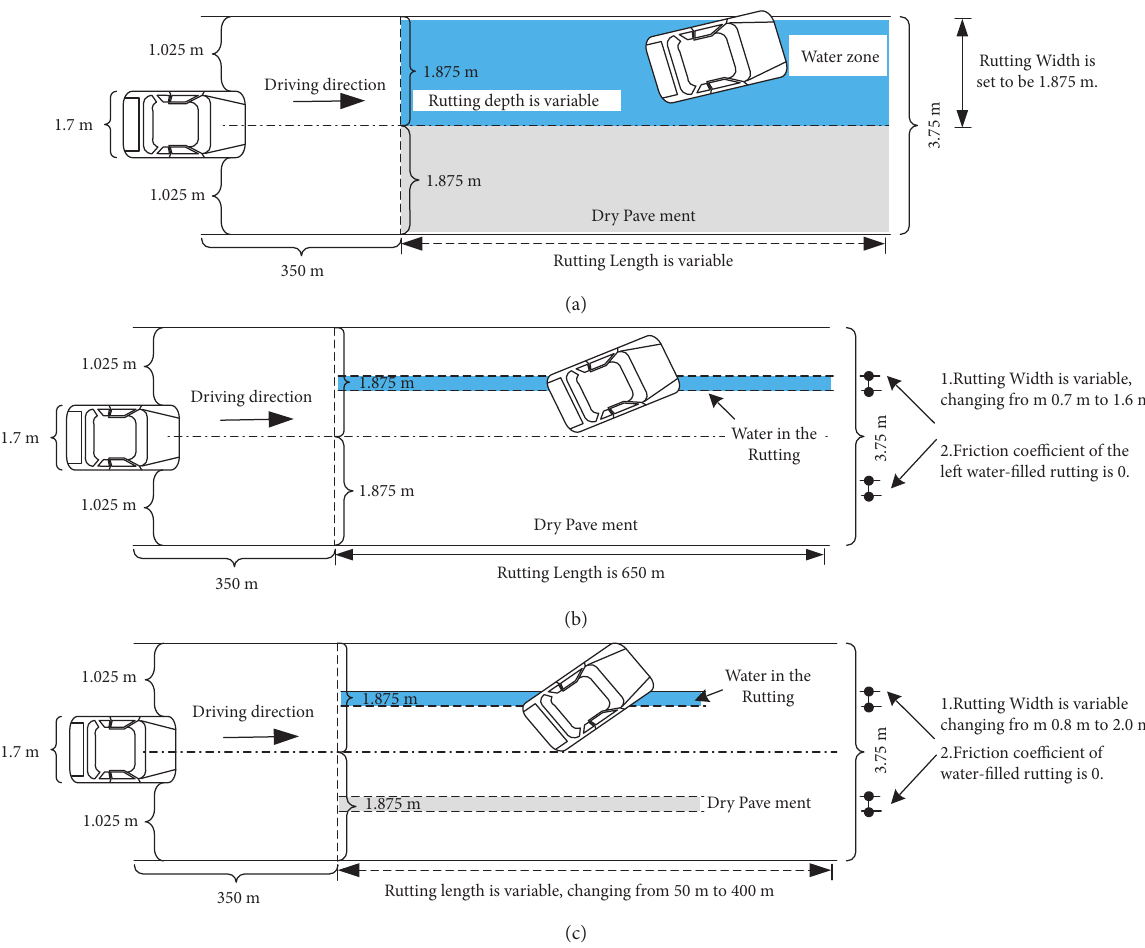
Figure 7: “Vehicle-water-filled rutting” open-loop dynamics model. (a) Analysis model for the impact of water length and depth on vehicle lateral stability. (b) Analysis model for the impact of water width on vehicle lateral stability. (c) Analysis model for the combined impact of water width and length on vehicle lateral stability.